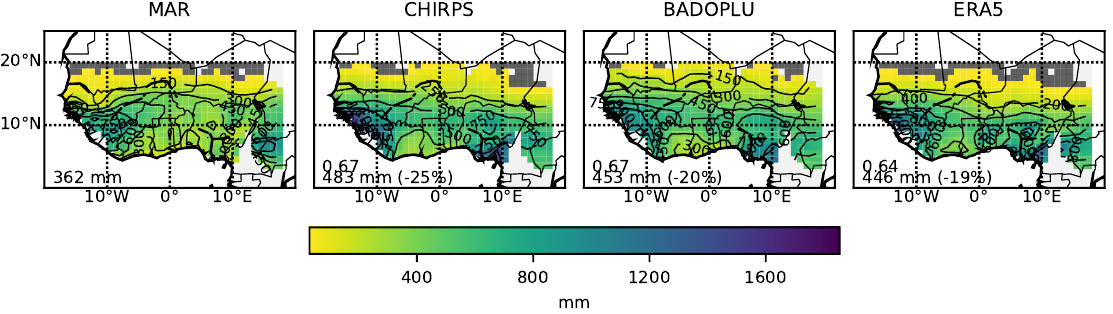
Figure 2. Study period averages of JAS total rainfall for MAR, CHIRPS, BADOPLU and ERA5 datasets. Grid cells with JAS rainfall amounts < 30 mm are ignored (dark grey shading), removing 11.0%, 7.3%, 3.2% and 15.5% of the MAR, CHIRPS, BADOPLU and ERA5 JAS total rainfall, respectively. Grid cells with missing value for at least one dataset are also ignored (light grey shading). Values in the bottom left corner are study domain mean values (mm), model anomalies relative to the comparative dataset (%) and spatial coefficient of correlation between the model outputs and each comparative